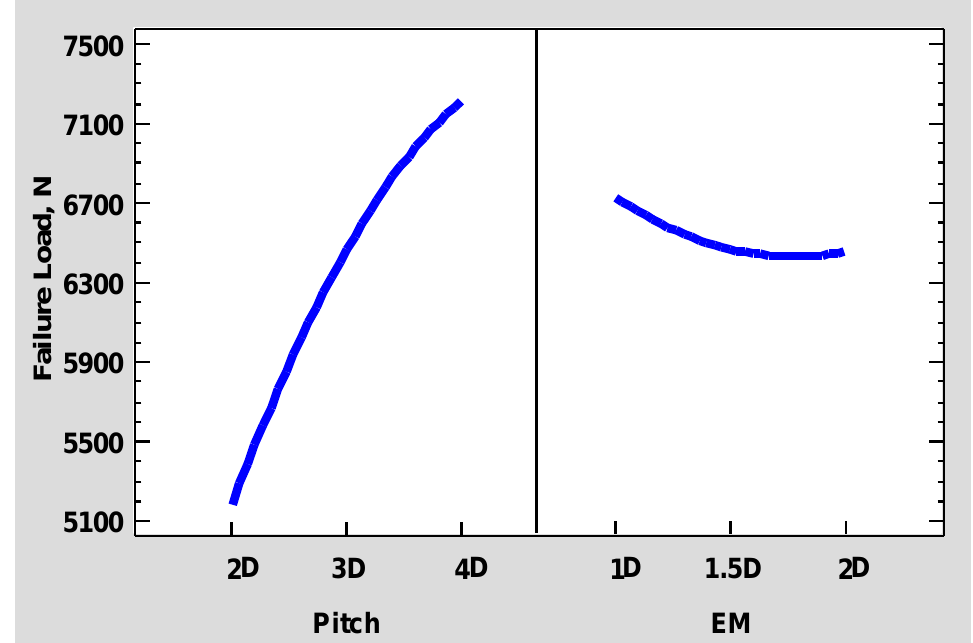
Figure 11. Main effects plot of the pitch and edge margin. The material edge was transverse to the loading direction. Notes: D = 7 mm (Spot Weld Diameter); pitch = Spot Weld Spacing; EM = Edge Margin.